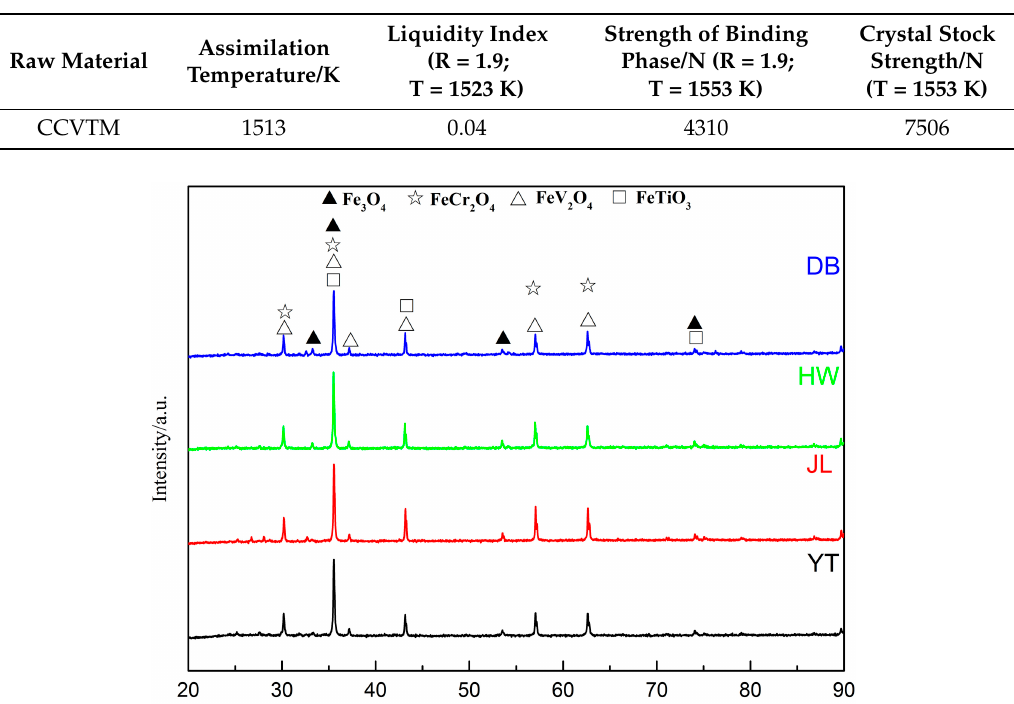
Figure 1. XRD patterns of the CCVTM (DB—Daban, HW—Henwei, JL—Jianlong, and YT—Yuantong).